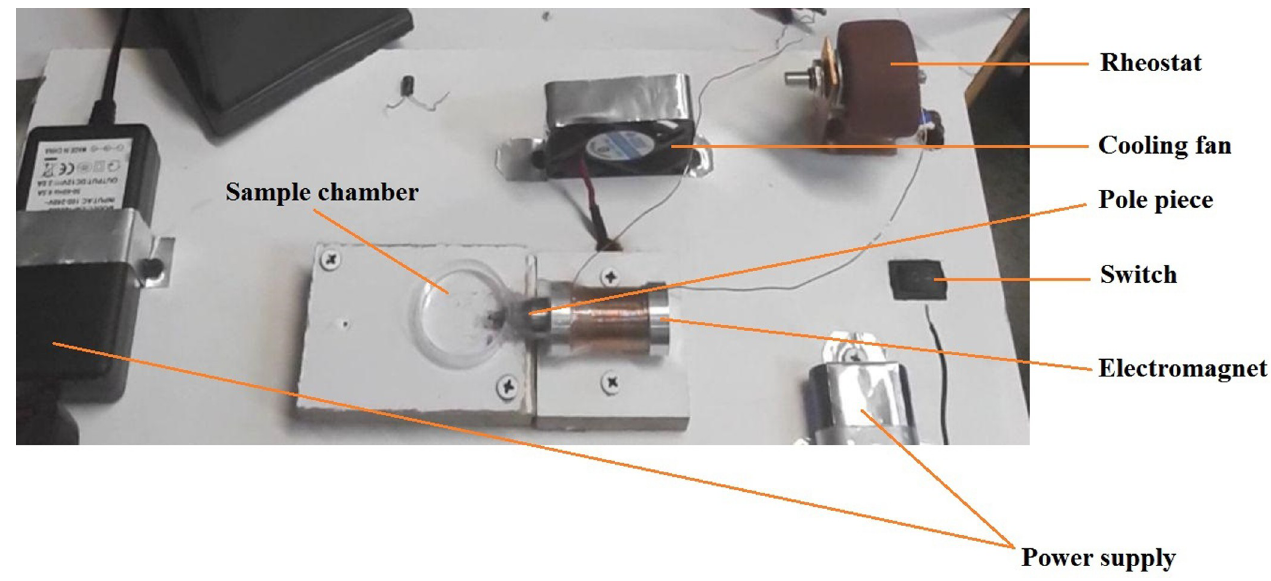
Fig 4. The image of the constructed AMBR set-up with the main